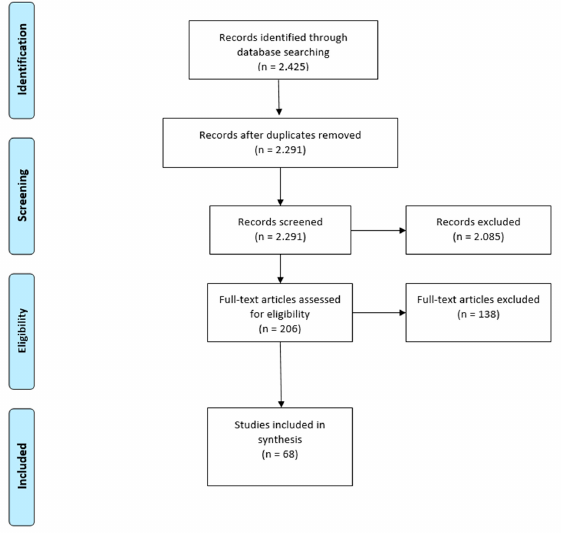
Figure 1. Screening chart.